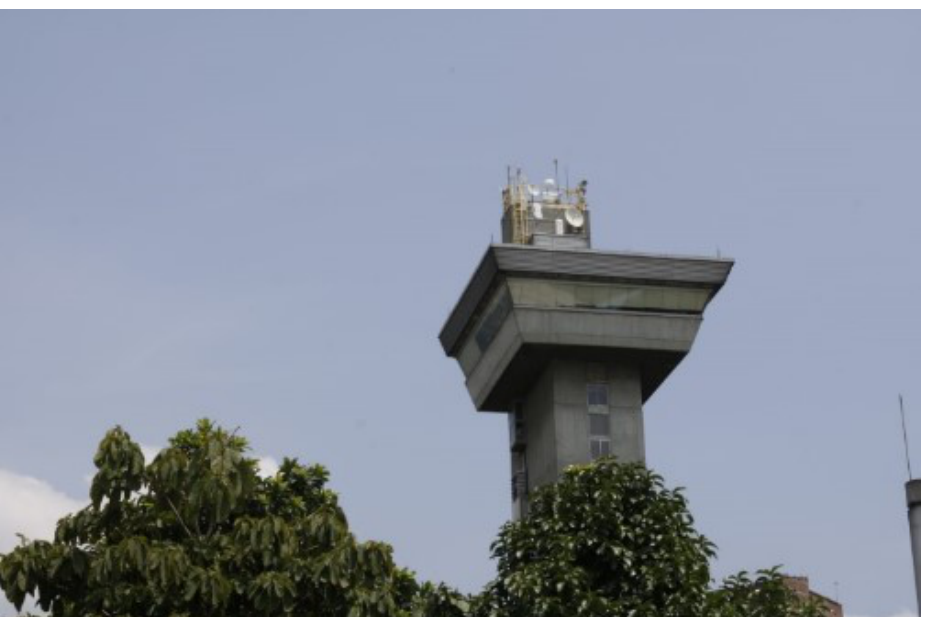
Figure 6. A picture of the Siata Tower Meteorological Station at Medellin, Colombia. Taken from [38].